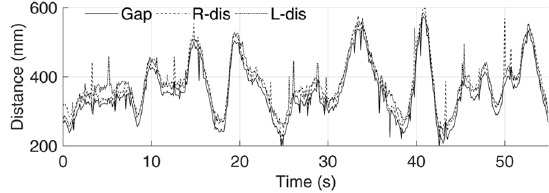
Figure 7 Gap perception based on the right and left laser range fi nders ’ measurements